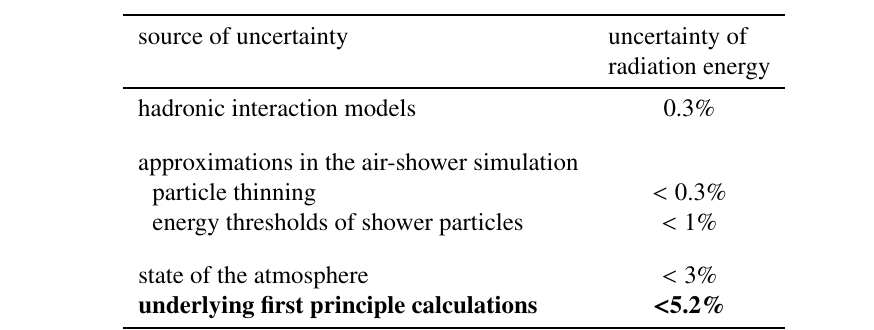
Table 1. Systematic uncertainties of the calculation of the radiation energy from the electromagnetic shower energy. Non-bold values taken from